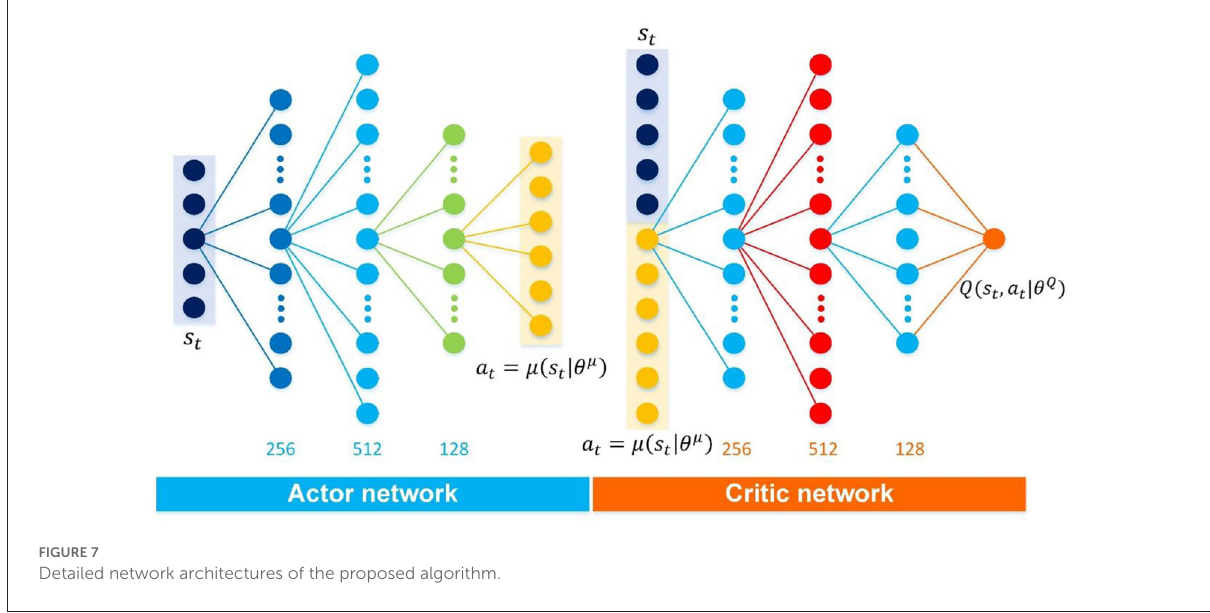
FIGURE7 Detailed network architectures of the proposed algorithm.